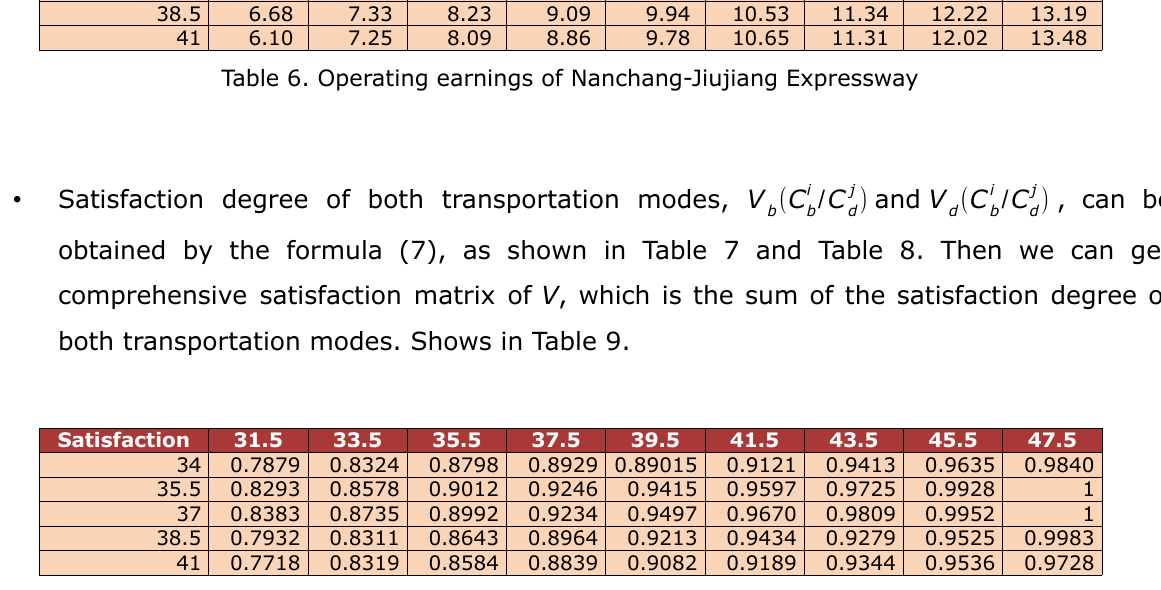
Table 7. Satisfaction of Nanchang-Jiujiang Inter-city High-speed Railway